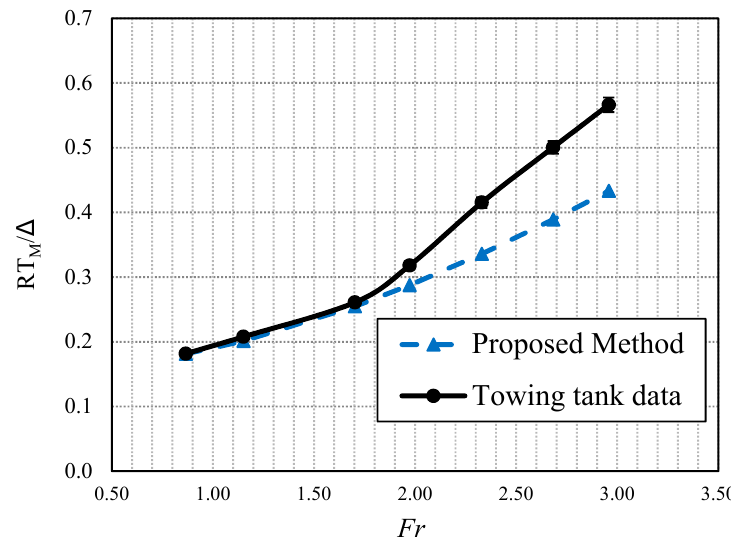
Figure 9. The non-dimensional resistance: 2D + T method vs. experimental results.